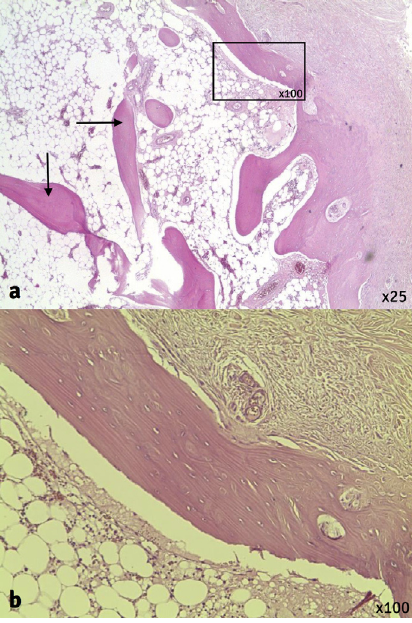
Fig. 6. Histopathological analysis (hematoxylin-eosin stain). a: magni fi cation (cid:3) 25: trabecular lamellar central bone (on the left side of the picture, arrows shows the trabecular bone) with peripheral cortical bone covered by a chorion (on the right side of the picture). b: magni fi cation (cid:3) 100: peripheral cortical A few lymphocyte or plasmocyte clusters were observed. These results con fi rmed the diagnosis of cortical spongy osteoma covered by slightly hyperplastic squamous epithelium.